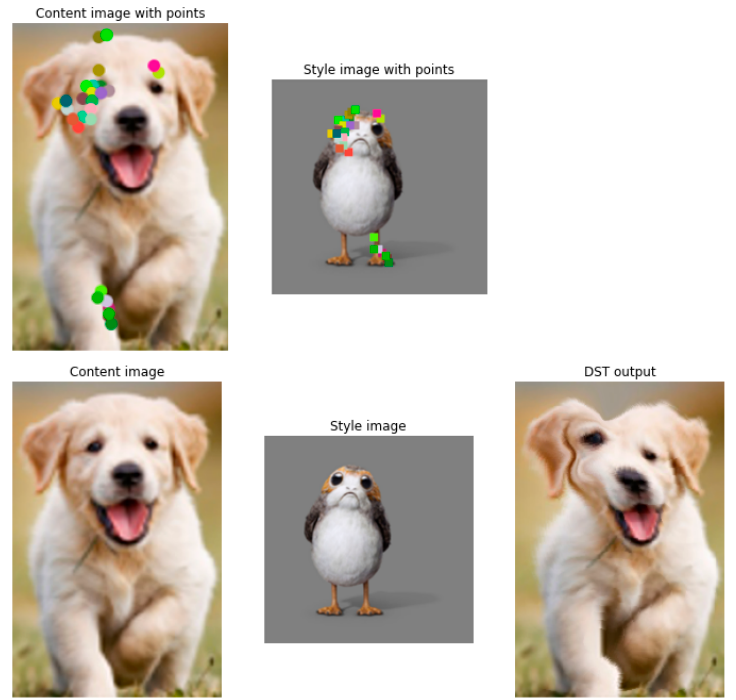
Figure 8. Results on two images whose features and alignment do not match.